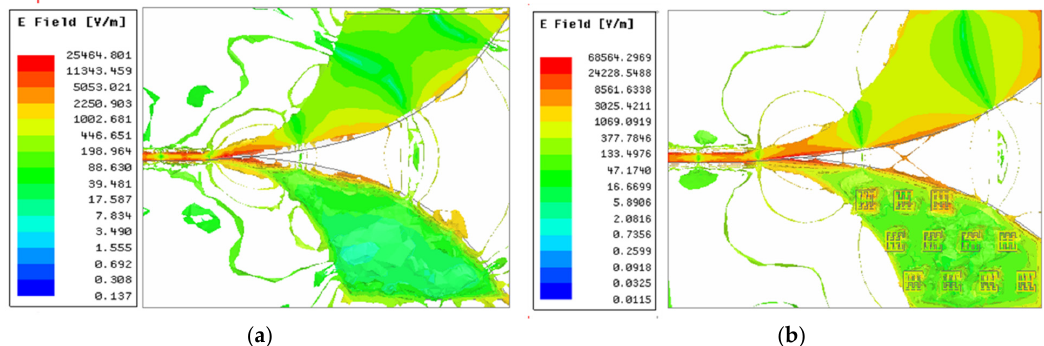
Figure 11. Electric field distribution in the Vivaldi antenna at 5 GHz ( a ) without and ( b ) with the metamaterial.